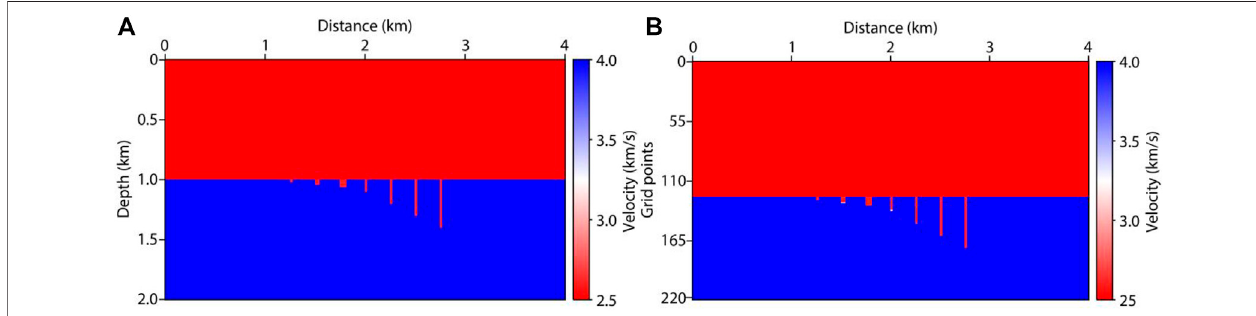
FIGURE 11 | Fractures-vugs model (A) and the resampled model (B) .